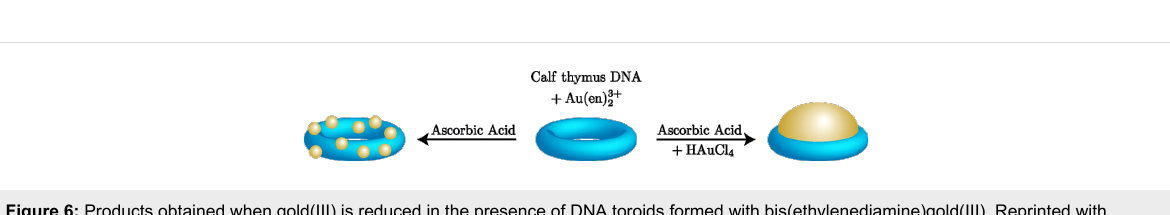
Figure 5: Schematic representation of the procedure applied for synthesizing starch/Ag nanocapsules. Reprinted with permission from [63]. Copy- right 2014 The Royal Society of Chemistry.